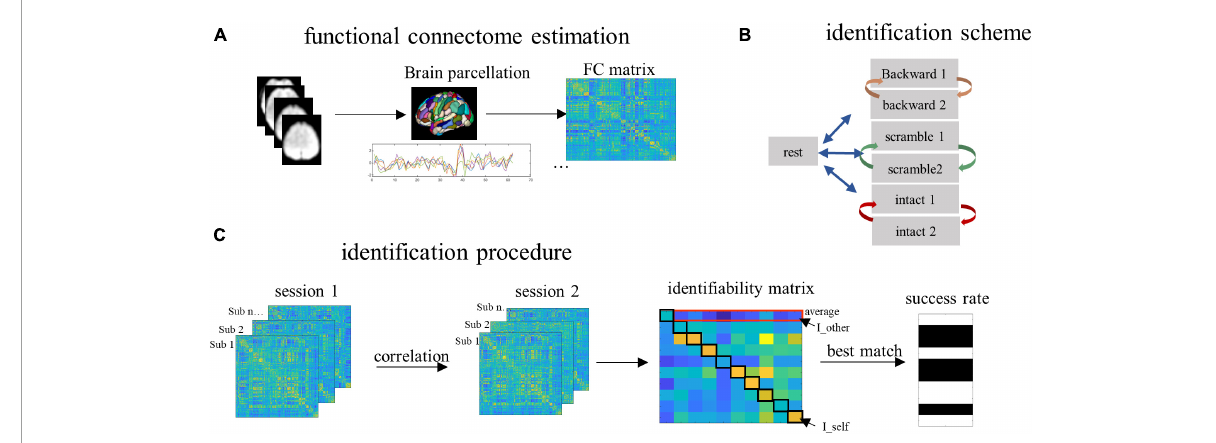
FIGURE2 The procedure of data analysis. (A) The whole brain was partitioned into 368 parcels. Time series corresponding to the task blocks were extracted and concatenated to compute the functional connectivity (FC). (B) To detect the contribution of task-independent brain processes, we paired the resting scan with each of the six task scans for the identification. To detect the contribution of low- and high-order brain processes, for each task condition, we paired the two successive scan sessions corresponding to the same task. (C) To predict subjects’ identities, the FCs from a database set were correlated with the FCs from the target set, resulting in an identifiability matrix. Based on this matrix, we obtained the within-subject FC similarity (quantified by the I_self), between-subject FC similarity (quantified by the I_other), individual identifiability (quantified by the I_diff, which is computed by I_self minus I_other), and the group-level success rate of